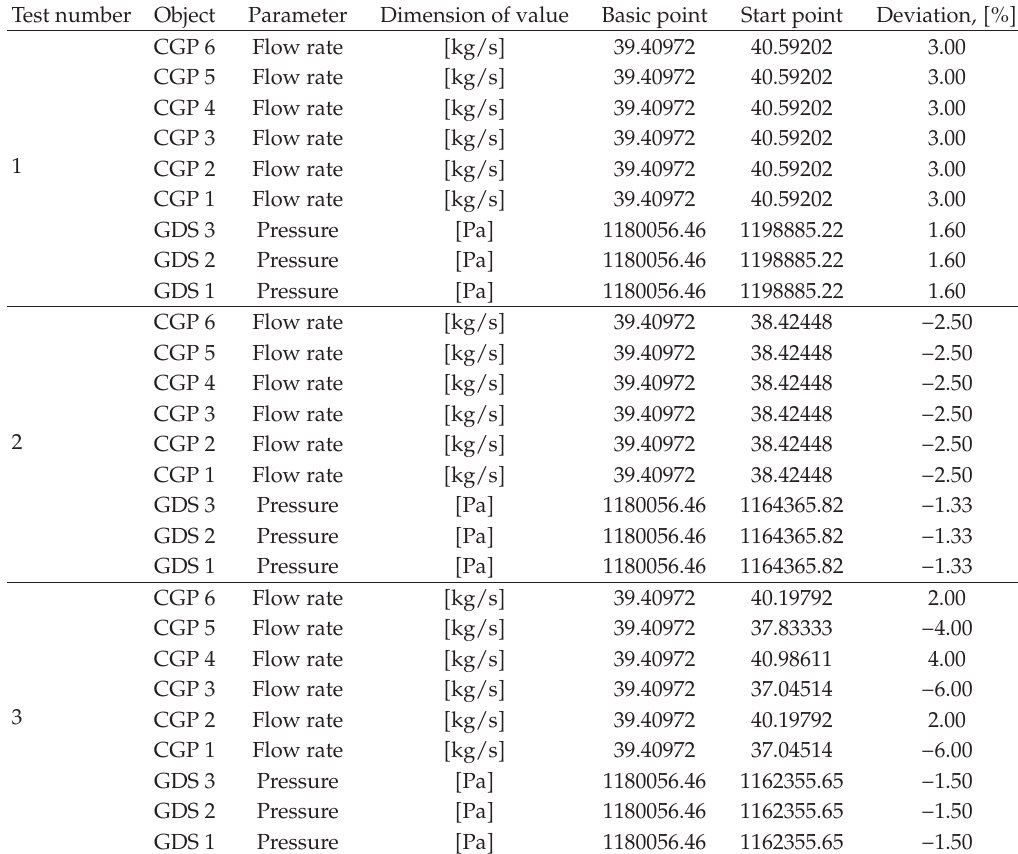
Table 6: Starting point of Stage 1 of the test simulation.